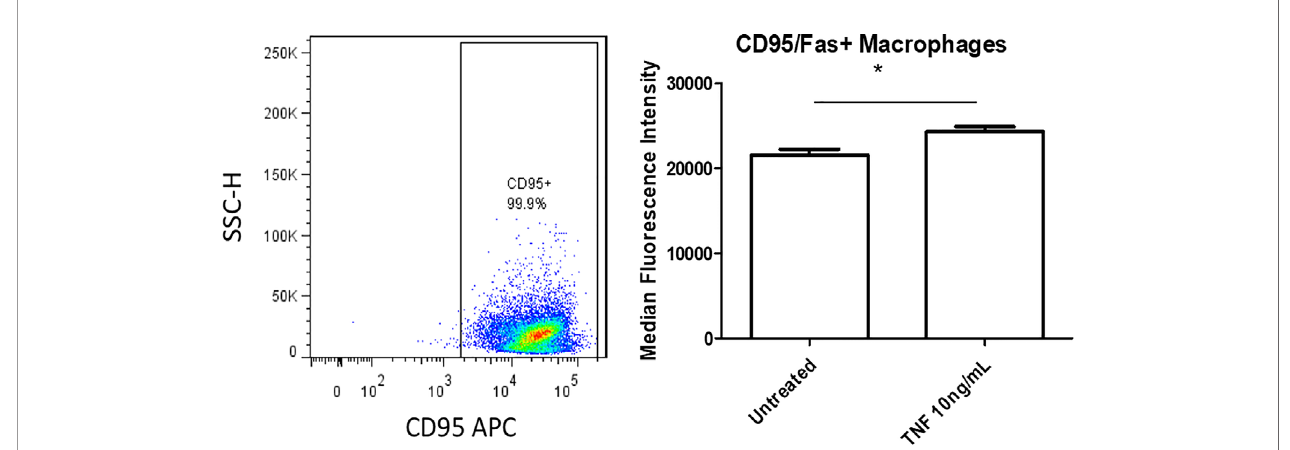
FIGURE 8 | TNF a -treated human peripheral blood mononuclear cells (PBMCs) show increased Fas expression. Isolated human PBMCs were grown for 7 days in macrophage differentiation medium. Cells were treated with TNF a (10ng/mL) for 24 hours. Untreated was incubated with fresh medium; Untreated (n=4), TNF a (n=4). * p